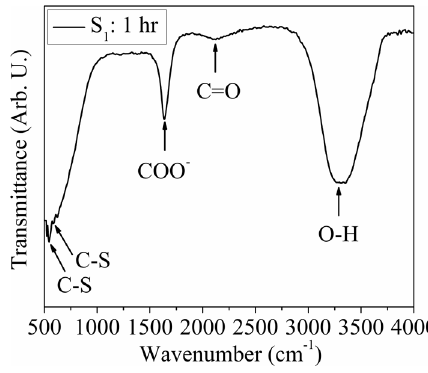
Fig. 9 FTIR spectrum of CdTe QDs for the sample S